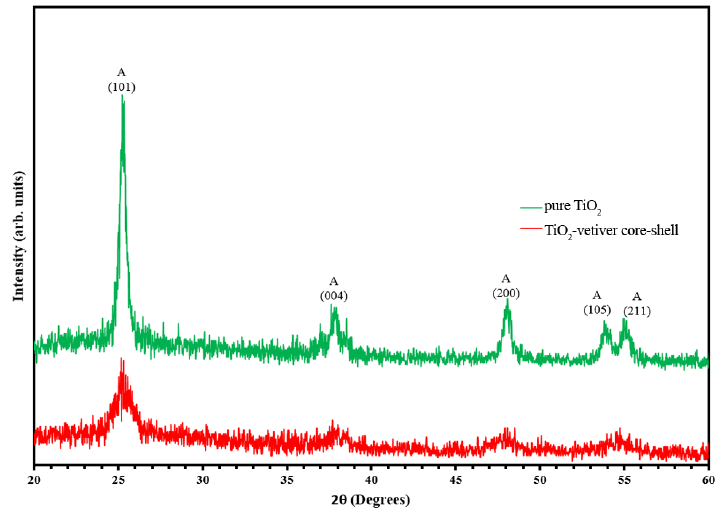
Figure 1. XRD patterns of pure TiO 2 and TiO 2 ‐ vetiver core–shell.